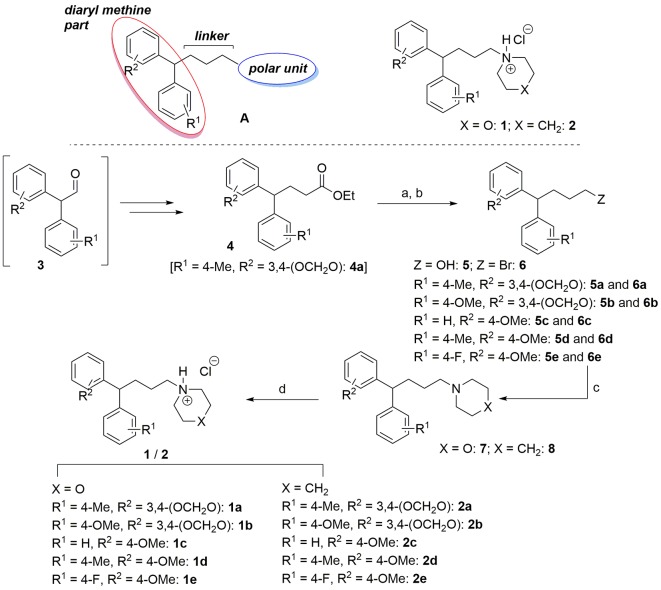
Proposed possible B0AT1 transporter inhibitors 1 and 2 and their synthesis. Reaction condition: (a) LiAlH4, THF, 0°C-rt, 6–7 h, 85–90%; (b) PPh3, CBr4, CH2Cl2, 0°C-rt, 24 h, 86–92%; (c) morpholine/piperidine, K2CO3, acetone, reflux, 20–22 h, 76–93%; (d) 4M HCl/Dioxane, CH2Cl2, rt, 24 h, 80–93%.